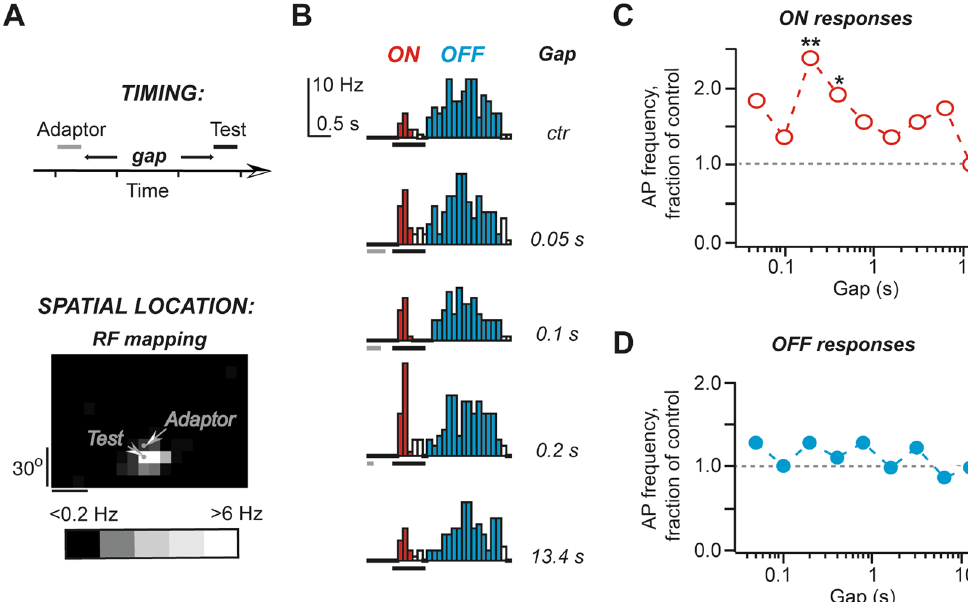
Figure 5. Facilitation can be observed when the adaptor stimulus is placed near small RF. ( A ) A schematic representation of the stimulation paradigm. ( B ) An example of response PSTHs. ( C ) The summary of ON responses obtained for unit shown in ( B ). ( D ) The summary of OFF responses obtained for unit shown in B .